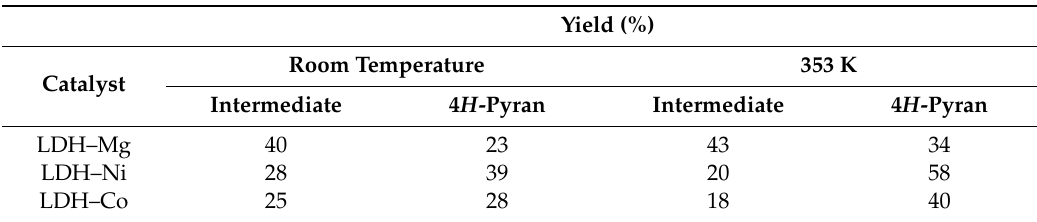
Table 4. E ff ect of the